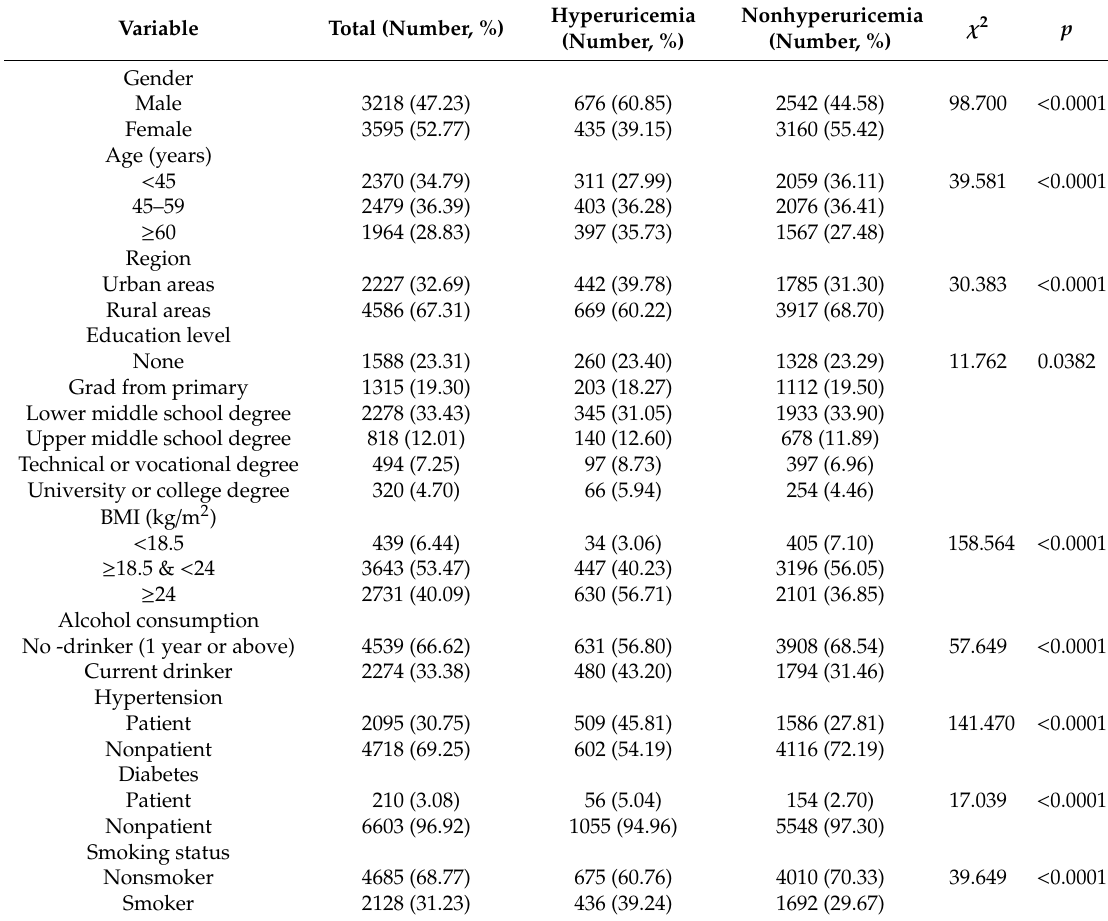
Table 1. Characteristics of hyperuricemia group and nonhyperuricemia group ( n = 6813).